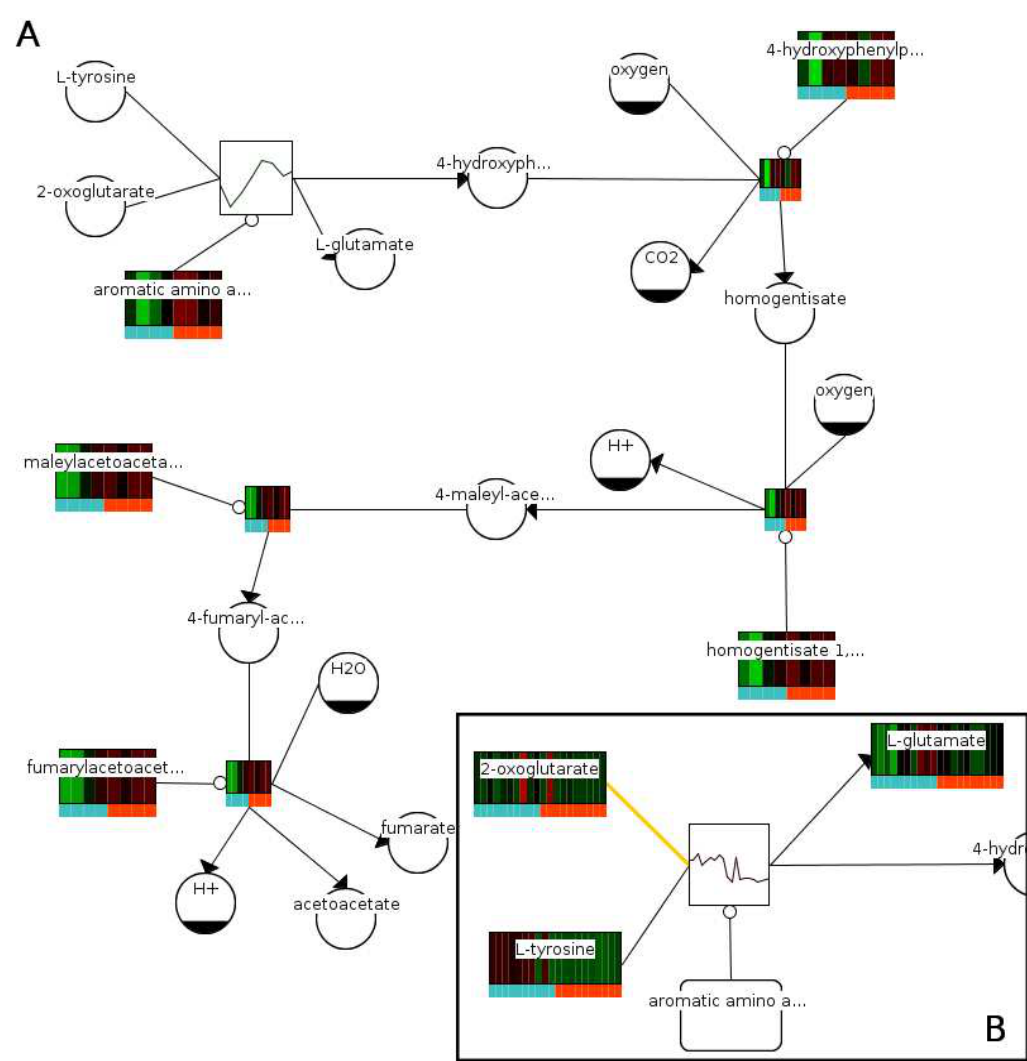
Figure 6: Tyrosine degradation pathway of Pseudomonas aeruginosa with integrated transcrip- tomic and metabolomic data. For comparability data has been z-score transformed. Experiments have been divided into two classes indicated by the color bars below the heatmaps: anaerobic and low oxygen conditions (light blue), aerobic conditions (orange). (A) The transcriptome data; (B) the metabolomics